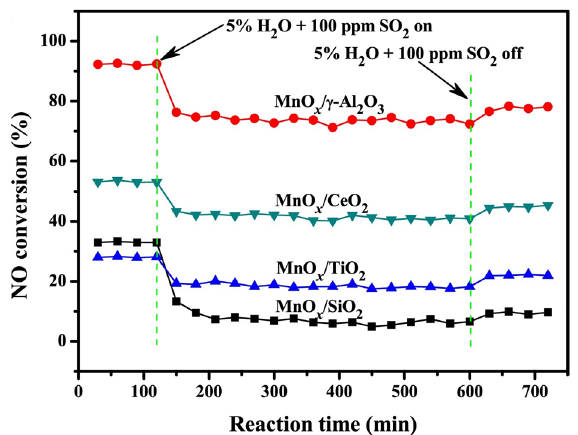
Figure 29. The results of H 2 O + SO 2 resistance at 200 °C of these supported Mn ‐ based catalysts with different supports. (Reproduced with permission from Reference [87], Copyright 2017, Elsevier.).